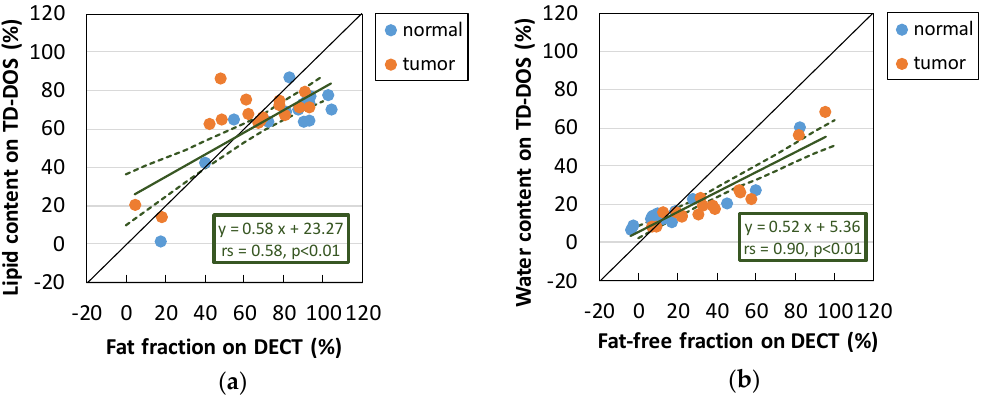
Figure 5. Measurement of normal breast tissue and breast tumor tissue in the supine position. ( a ) Relationship between lipid content estimated by TD-DOS and fat fraction estimated by DECT. ( b ) Relationship between the water content obtained by TD-DOS and the fat-free fraction obtained by DECT. The solid line on the inset is a regression line; the dashed lines represent the 95% confidence limits. (n = 16)